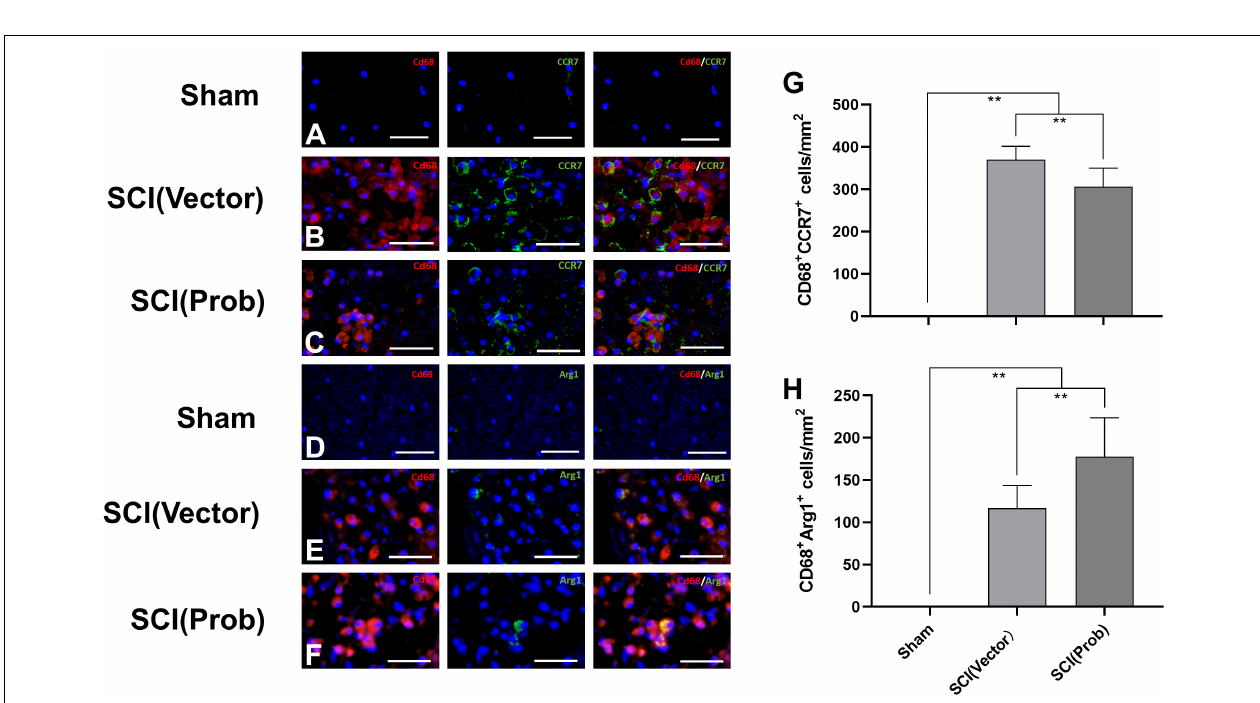
FIGURE 3 | Effects of Probenecid on M1 and M2 cells in the injured spinal cord as distinguished by immunofluorescence. Representative images of CD68 (red, rhodamine staining) and CCR7 (green, FITC staining) co-stained M1 cells (A–C) , CD68 (red, rhodamine staining) and Arg1 (green, FITC staining) co-stained M2 cells (D–F) . Cells were counterstained with Hoechst 33342 (blue) to visualize nuclei. (G,H) Quantitative analysis of CD68 + CCR7 + (G) , and CD68 + Arg1 + ( H ; ** p < 0.01 n = 6), scale bar: 50 µ m.